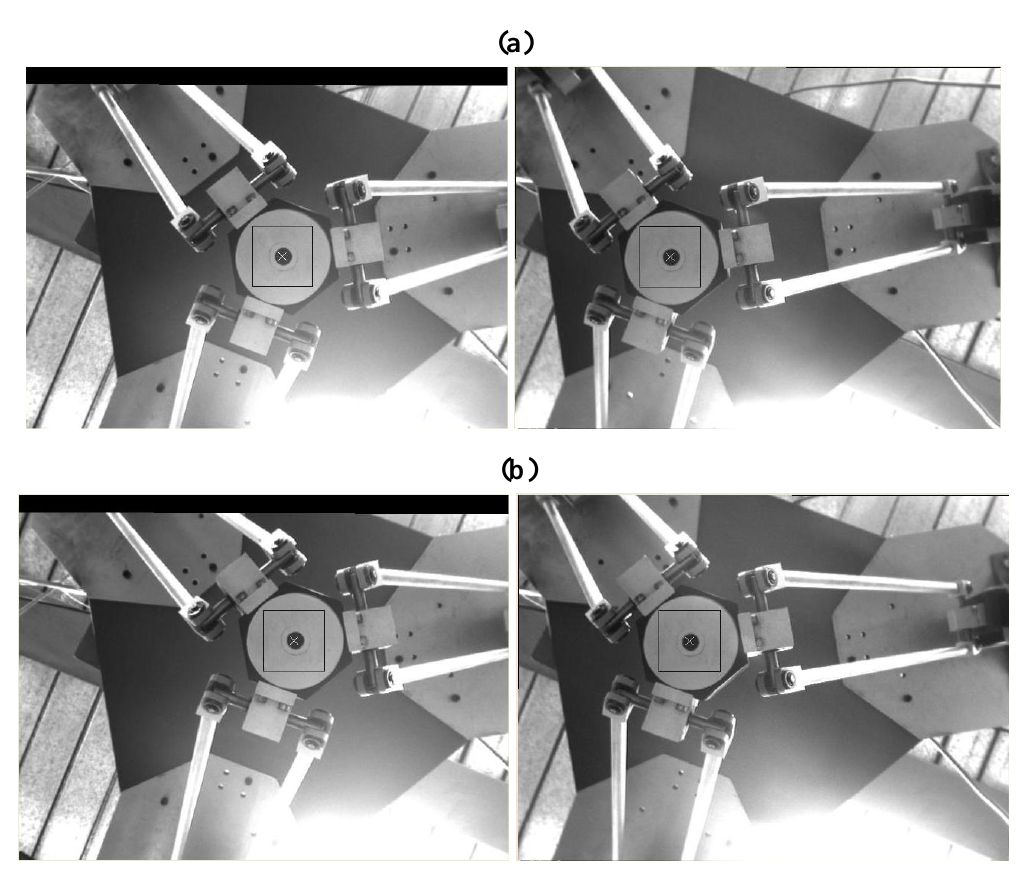
Figure 12. Left and right image stereo tracking results when the target at an arbitrary position A (a) , position B (b) and position C (c)